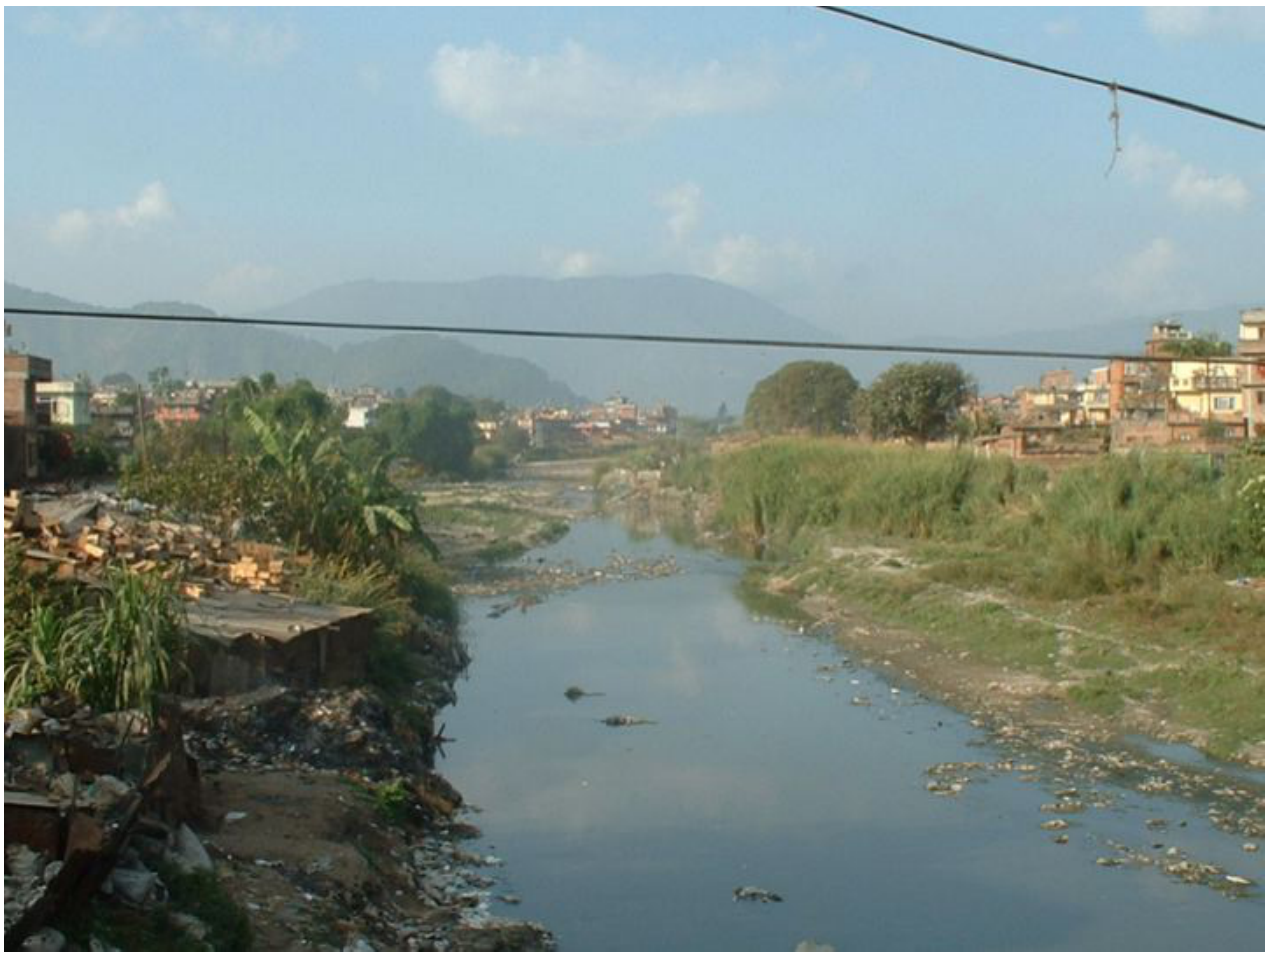
Fig. 10 . The bank of the Bishnumati River adjacent to Wards 19 and 20, Kathmandu,